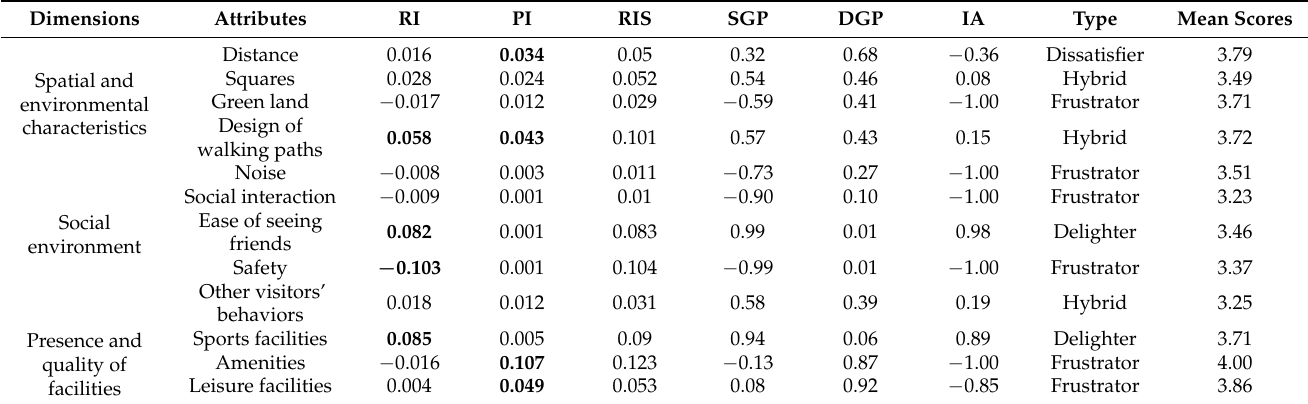
Table 3. Results of IRPA and